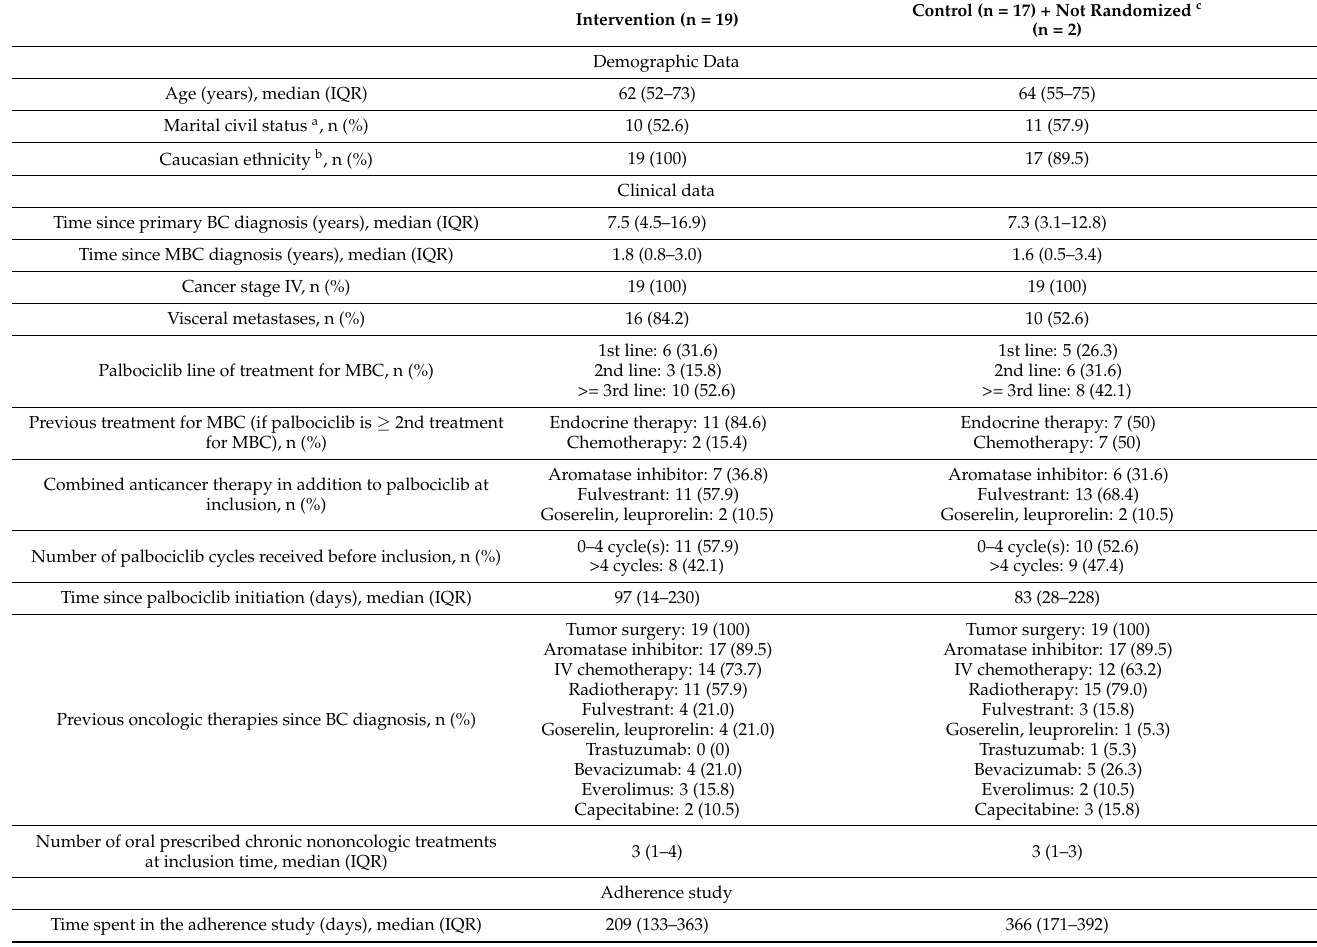
Table 1. Demographic and clinical data of patients treated with palbociclib in the OpTAT study (n =